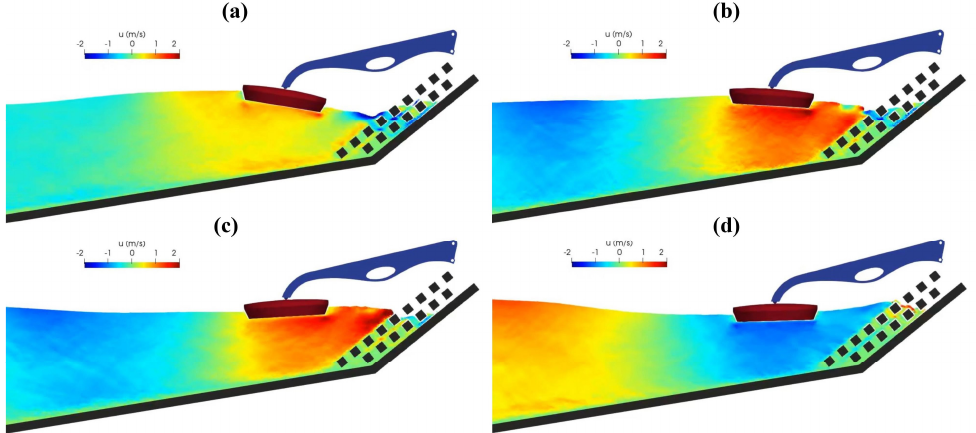
Figure 10. Snapshots of different instants of the velocity field in the vicinity of the WEHC device for H = 2 m and T = 7 s with porous breakwater at ( a ) t = 100 s, ( b ) t = 102 s, ( c ) t = 104 s and ( d ) t = 107